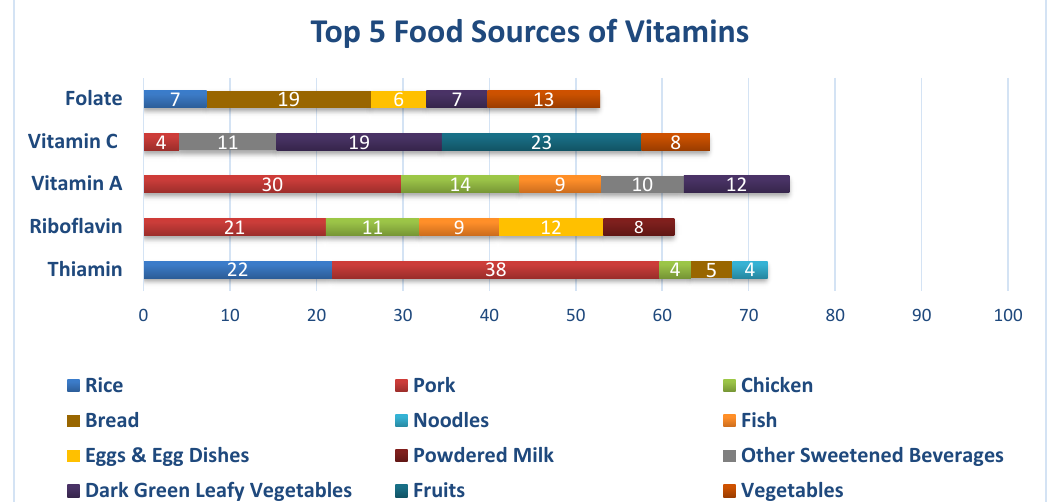
Figure 4. Percentage contributions of each food group to the vitamin intake of Filipino working adults.